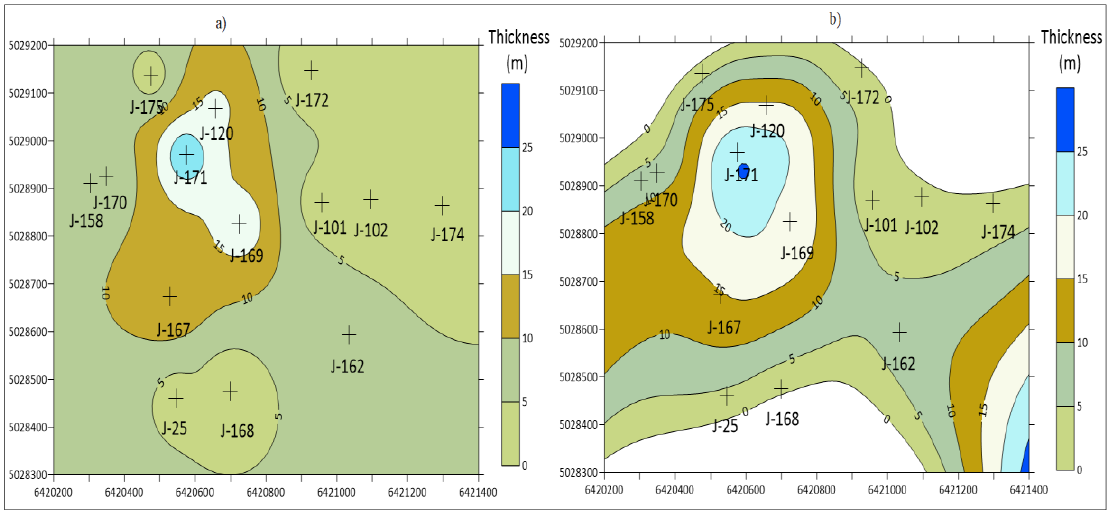
Figure 10. Thickness of reservoir “K”: ( a ) IDW; ( b ) MSM.